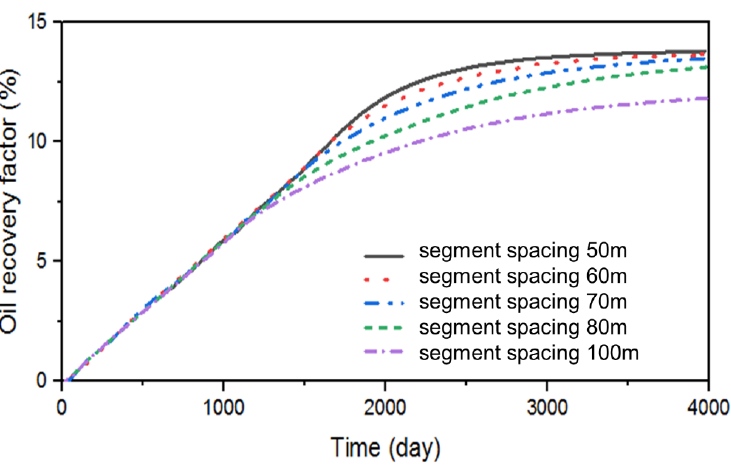
Figure 6. The comparison of oil recoveries under different segment spacings.